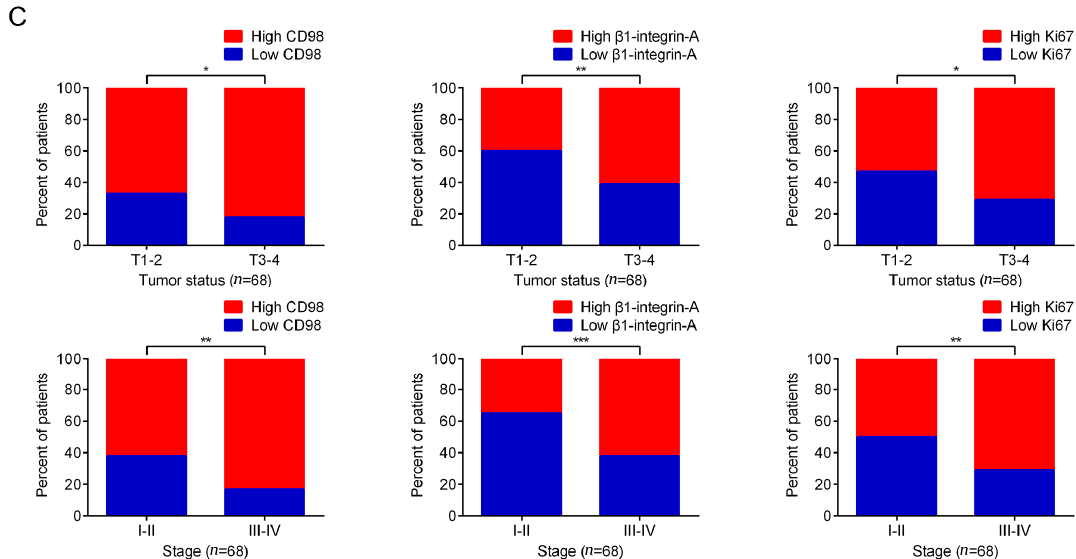
Figure 5. Coordinated expression of CD98, β 1-integrin-A and Ki-67 in HCC patient specimens determined by immunohistochemical analysis. ( A ) Representative images of immunohistochemical staining of CD98, β 1-integrin-A and Ki-67 using consecutive tissue sections from same HCC patients (Scale bars, 100 μ m); ( B ) scatter plot analysis of the correlation between protein expression levels of CD98, β 1-integrin-A and Ki-67 in 68 HCC tissues. The dots on the graphs represent more than one specimen; ( C ) the expression of CD98, β 1-integrin-A and Ki-67 was positively correlated with tumor size and disease stage (* p < 0.05, ** p < 0.01, *** p < 0.001).